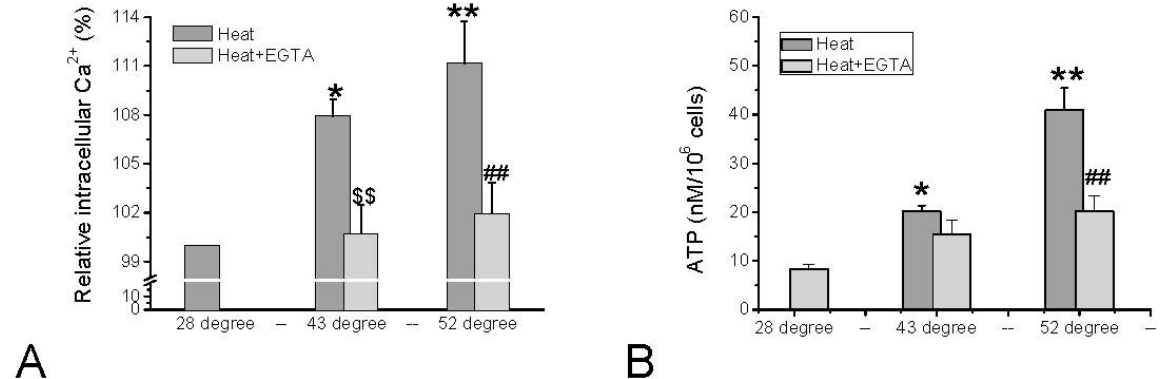
Figure 4. Changes in [Ca 2+ ] and extracellular ATP in HMC-1 cells in response to noxious i heat that activates TRPV1 (43 °C) and TRPV2 (52 °C), and either in the absence (dark grey bars) or presence (light grey bars) of 5 mM EGTA. ( A ) Quantitative analysis from several sets of experiments normalized to basal [Ca 2+ ]i–dependent fluorescence at 28 °C (=100% of Calcium Green-1 loaded HMC-1 cells). Data represent averages ± SEM from N = 3–4 independent experiments (* p < 0.0 5, ** p < 0.01, compared to 28 °C; $$ p < 0.01 compare to 43 °C, ## p < 0.01, compared to 52 °C); ( B ) ATP content in cell suspension after 3 min of incubation at the respective temperatures. Data represent averages ±SEM from n = 6–42 samples of N = 3–11 independent experiments (* p = < 0.05 and ** p < 0.0001, compared to control; ## p < 0.0001, compare to 52 °C). Data in ( A) are unpublished, data in ( B ) are based on Hu et al. 2014